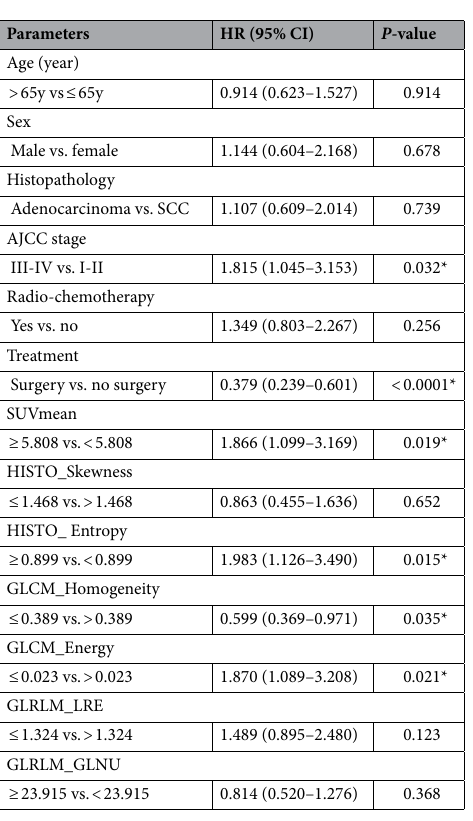
Table 3. Univariate analysis of both clinical and textural factors with RFS. HR hazard ratio, CI confidence interval, AJCC American joint committee of cancer, SCC squamous cell carcinoma, SUV standardized uptake value, HISTO histogram, GLCM grey level co-occurrence matrix, GLRLM grey level run-length matrix, LRE long run emphasis, GLNU gray level non-uniformity for run. *Significant P -value (<